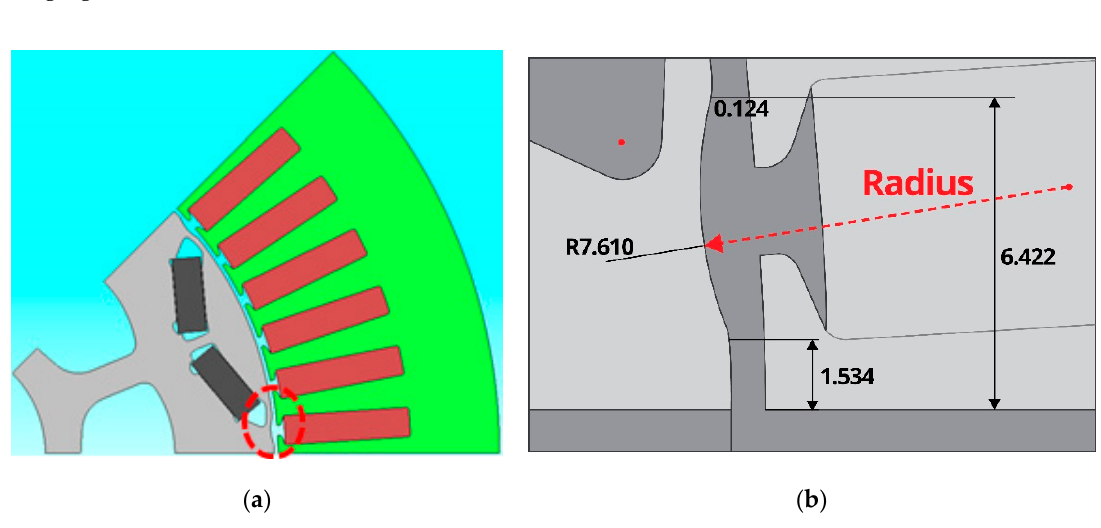
Figure 4. Notch shape optimization: ( a ) notch optimization position; ( b ) notch optimization diagram.